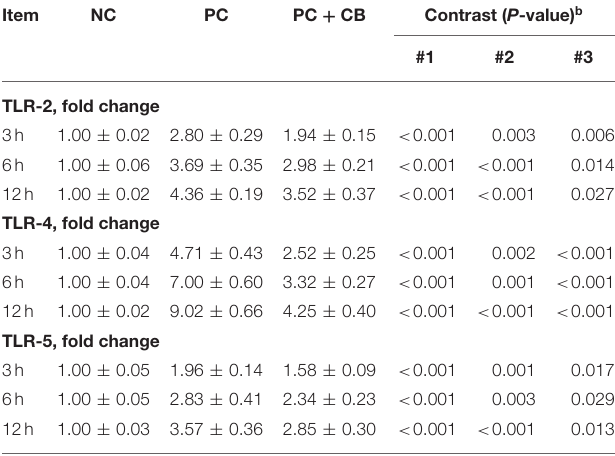
TABLE 4 | Effect of CB on the mRNA expression of TLR-2, TLR-4, and TLR-5 in ETEC K88-infected piglets a .